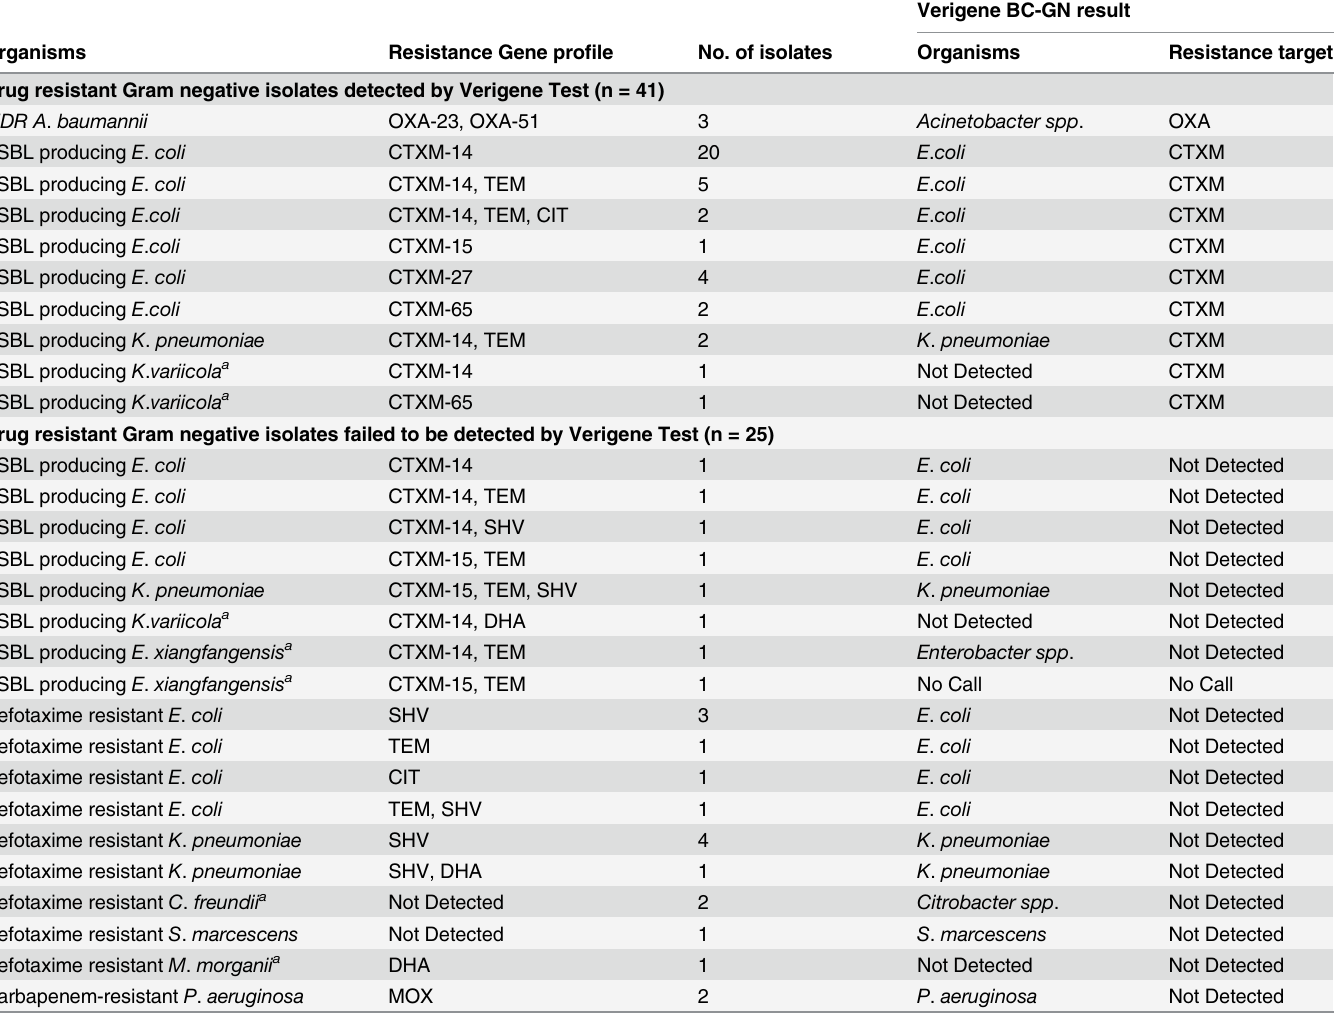
Table 6. Resistance gene profile in Gram negative organisms collected in this